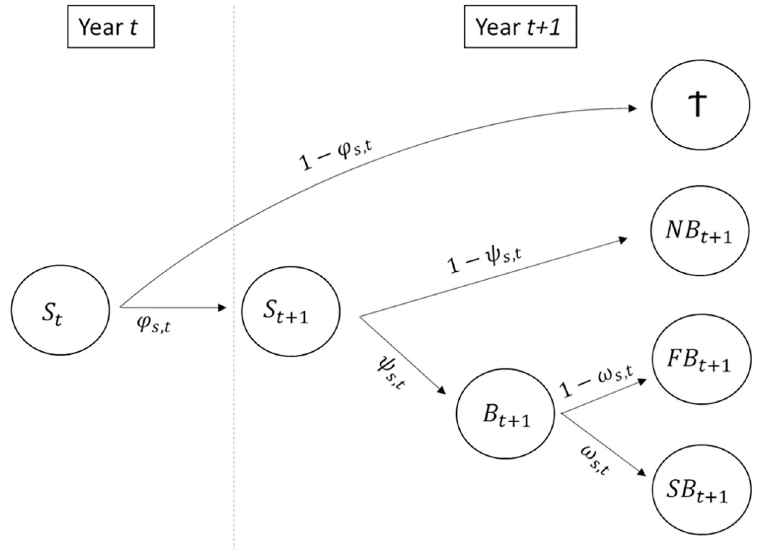
Fig 2. Schematic of the multi-state model structure used to estimate survival ( ϕ ), breeding propensity ( ψ ) and breeding success ( ω ) of Manx shearwaters between 1993 and 2019 on Skomer Island. At the first occasion, birds can be observed in one of three breeding states ( r ) in the model: non breeder (NB), failed breeder (FB) or successful breeder (SB). The model then describes the transition between states from year t to t + 1 as three conditional steps. The first step estimates the probability of an individual in a given state ( r = NB, FB or SB) surviving from year t to t + 1 ( � r ). The second step estimates the probability of surviving birds attempting to breed ( B ) in year t + 1 , given their t breeding state in year t ( c r ). Finally, the third step estimates the probability that birds attempting to breed in year t + 1 t successfully fledge a chick, given their breeding state in year t ( o r t